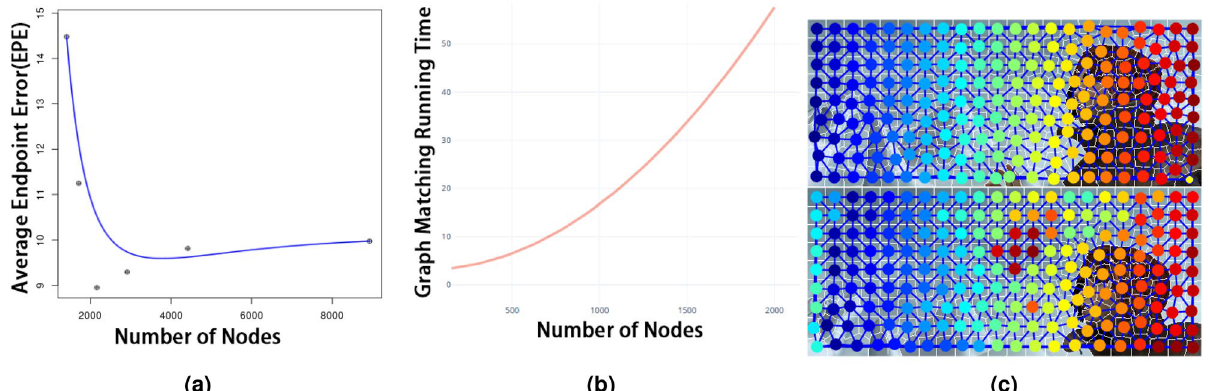
Figure 4. ( a ) Average end-point error (EPE) w.r.t number of graph nodes per image( 1024 × 436 ).( b ) Average graph-matching time complexity(s) w.r.t. number of graph nodes. We empirically determine the optimal number of superpixels by performing graph matching using different superpixel sizes and calculate the EPE of the resulting optical flow. Optimal size is found to be | s | ≈ 300 . ( c ) Ablation: Graph matching using SLIC clusters as the initial coarse-scale-clusters instead of clustering the feature descriptors. Superpixel clustering results in a near-rigid pixel grid that, as can be seen, is not robust to occlusions. The number of superpixels is set to 200. The first and second columns show the colour-coded matches of the graph nodes using graph matching based on an initial coarse-scale clustering of superpixels